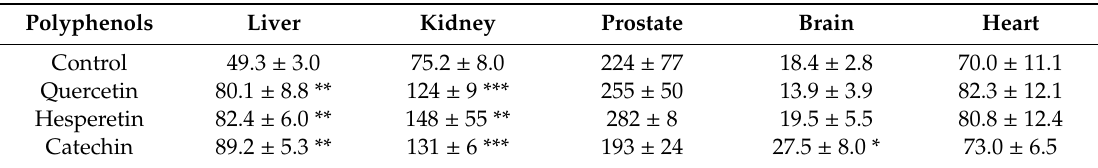
Table 1. FRAP Antioxidant Capacity ( µ mol / kg. i.e., µ M) in Di ff erent Rat Organs after Three Separate PP were Administered to Three Di ff erent